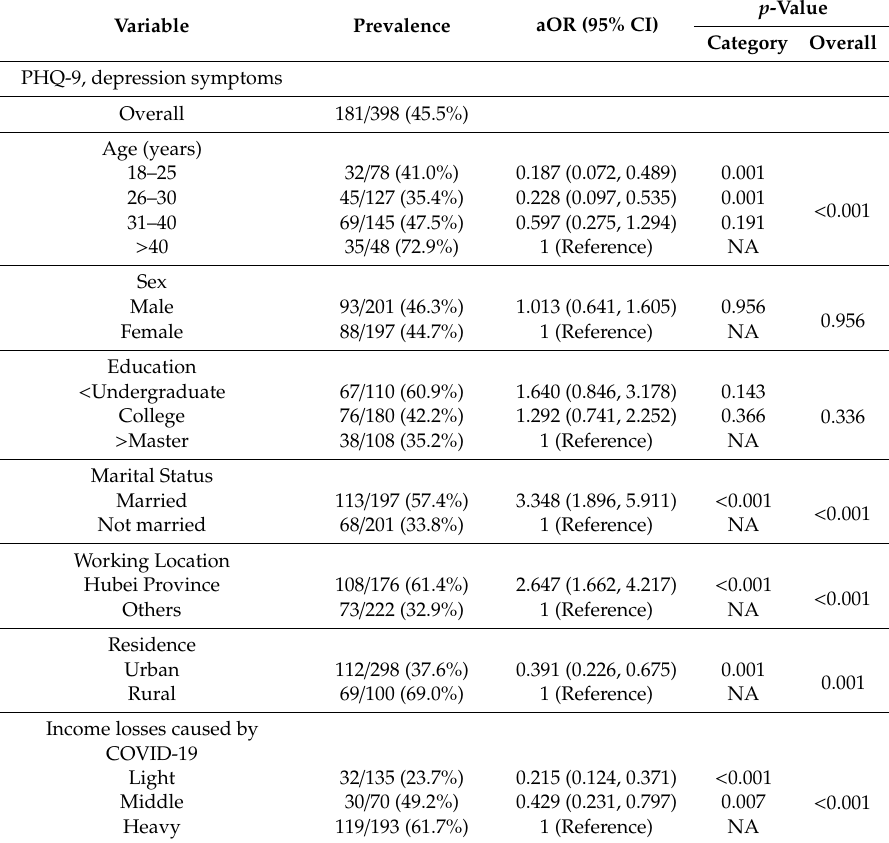
Table 2. Prevalence of depression and associated factors.